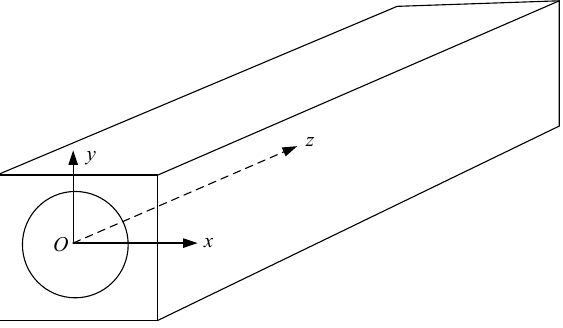
Figure 2. SAFE (semi-analytical finite element) model of a square drill pipe.